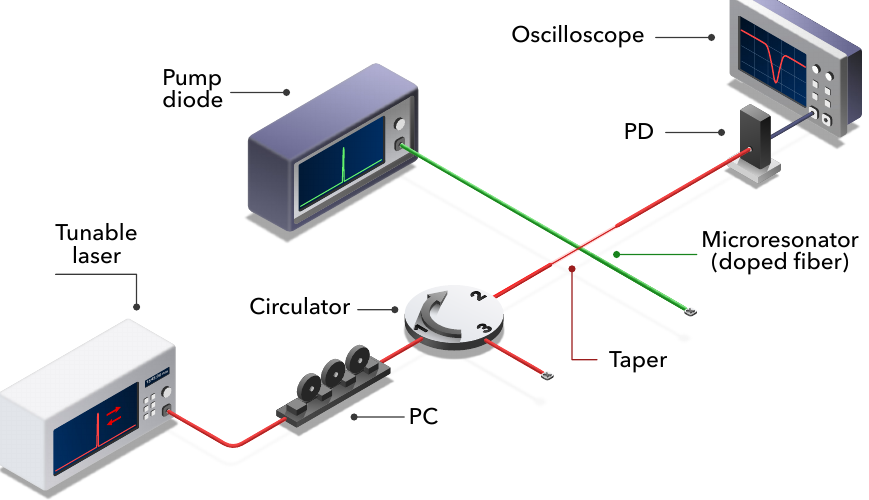
Figure 2. Scheme of the experimental setup employed to characterize the temperature increment by means of the whispering gallery modes (WGMs). PD, photodiode; PC, polarization